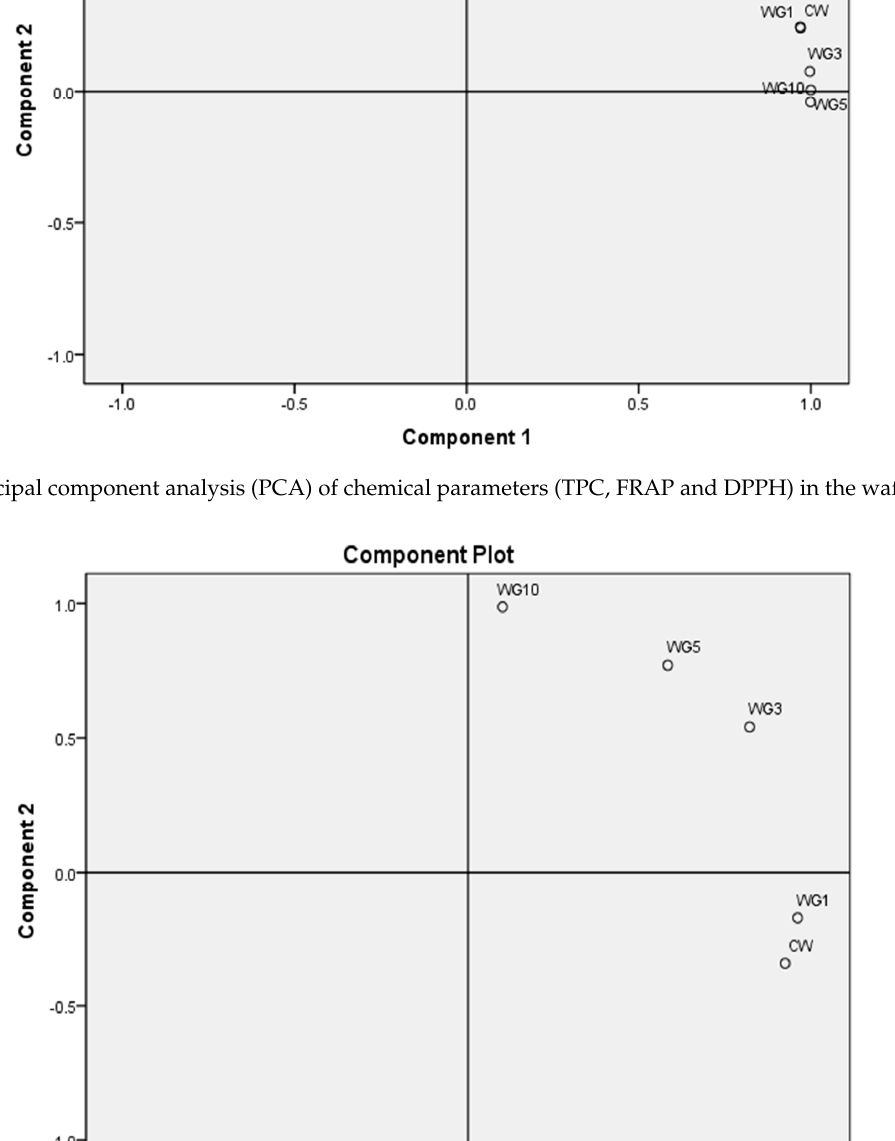
Figure 2. Principal component analysis (PCA) of sensory properties in the waffle samples.